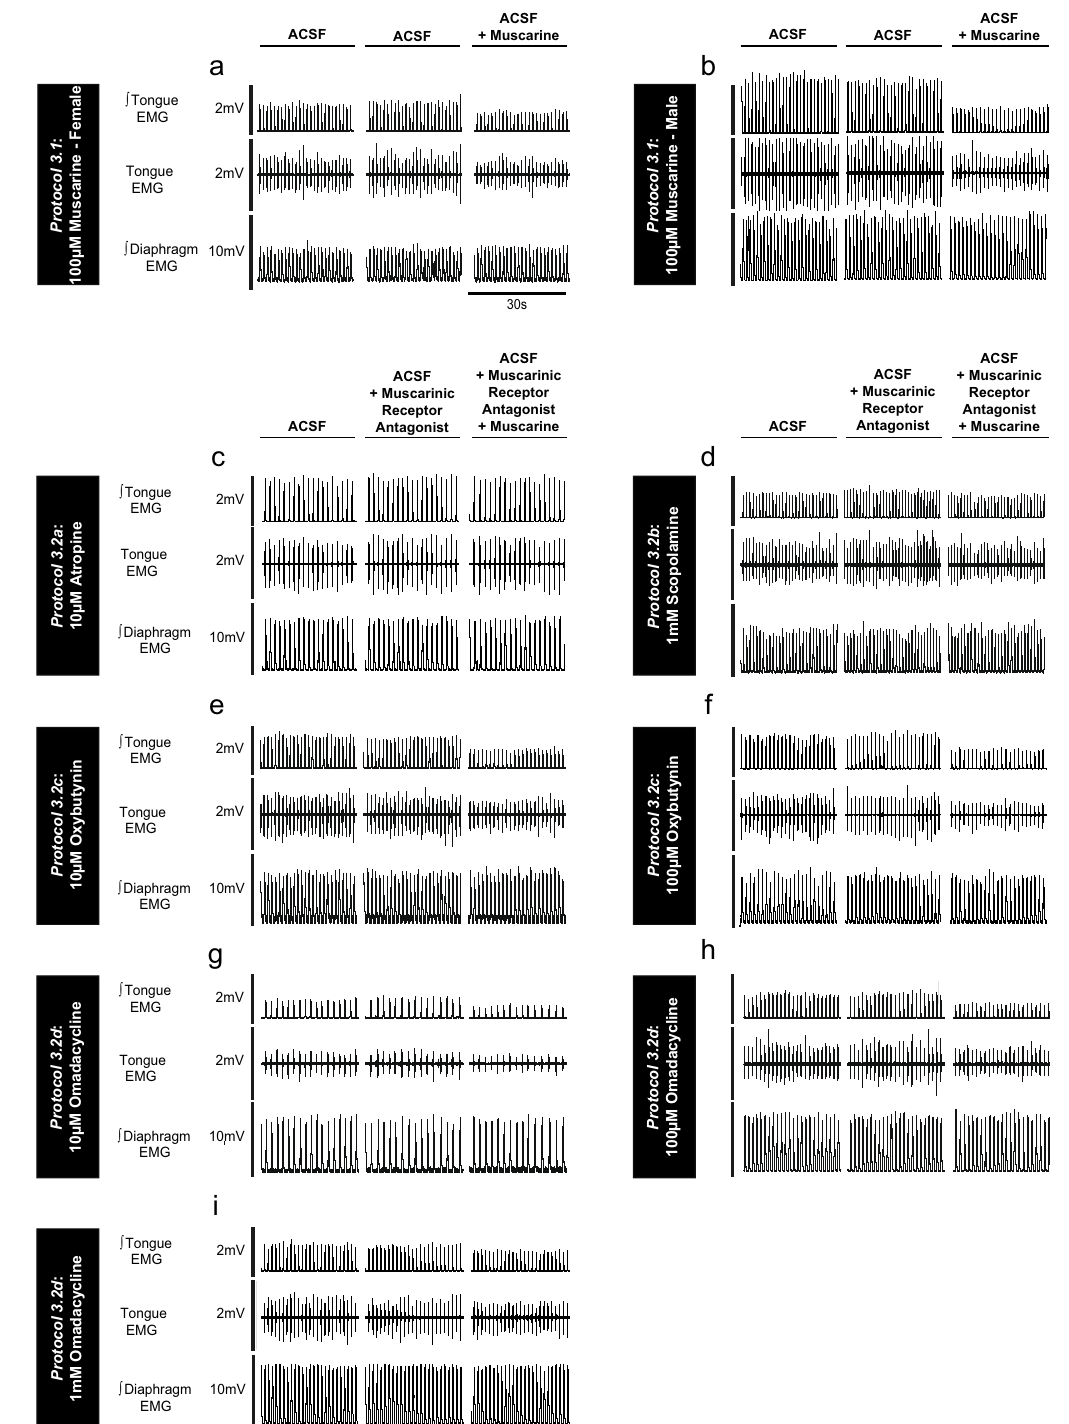
Figure 9. Example traces showing tongue motor inhibition by muscarine at the HMN ( Protocol 3.1 ) and the capacity for its blockade by muscarinic receptor antagonists ( Protocol 3.2a‑d ). The sets of traces ( a – i ) show the raw tongue EMG activity, and the moving time averages (∫) of the tongue and diaphragm EMG signals during microperfusion of muscarine in female and male rats ( a , b ) or when co-applied with muscarinic receptor antagonists in male rats ( c – i ). The 30-s sample traces represent the last minute of each intervention, with this last-minute period used for data